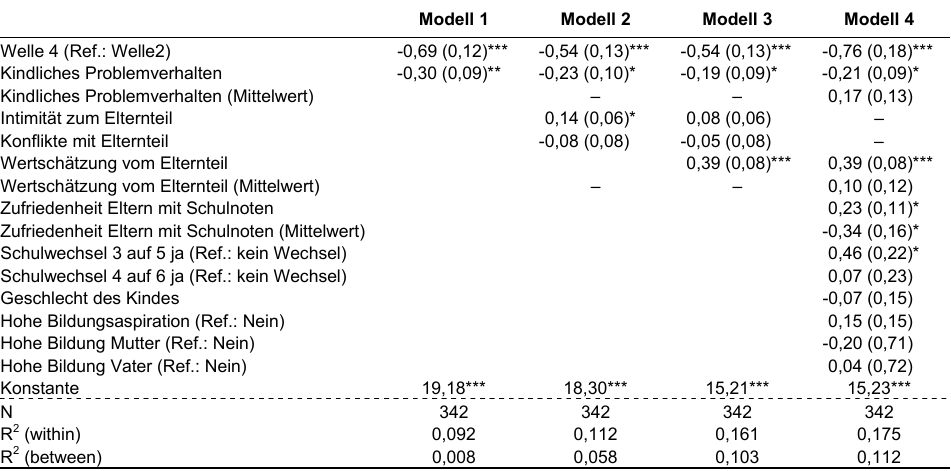
Tabelle 4 : Zwei-Wellen Panelregressionsmodell (Modell 1 bis 3 fixed-effects) des elterlichen Schulinteresses auf zentrale zeitveränderliche und zeitkonstante Einflussfaktoren (Modell 4 ist ein